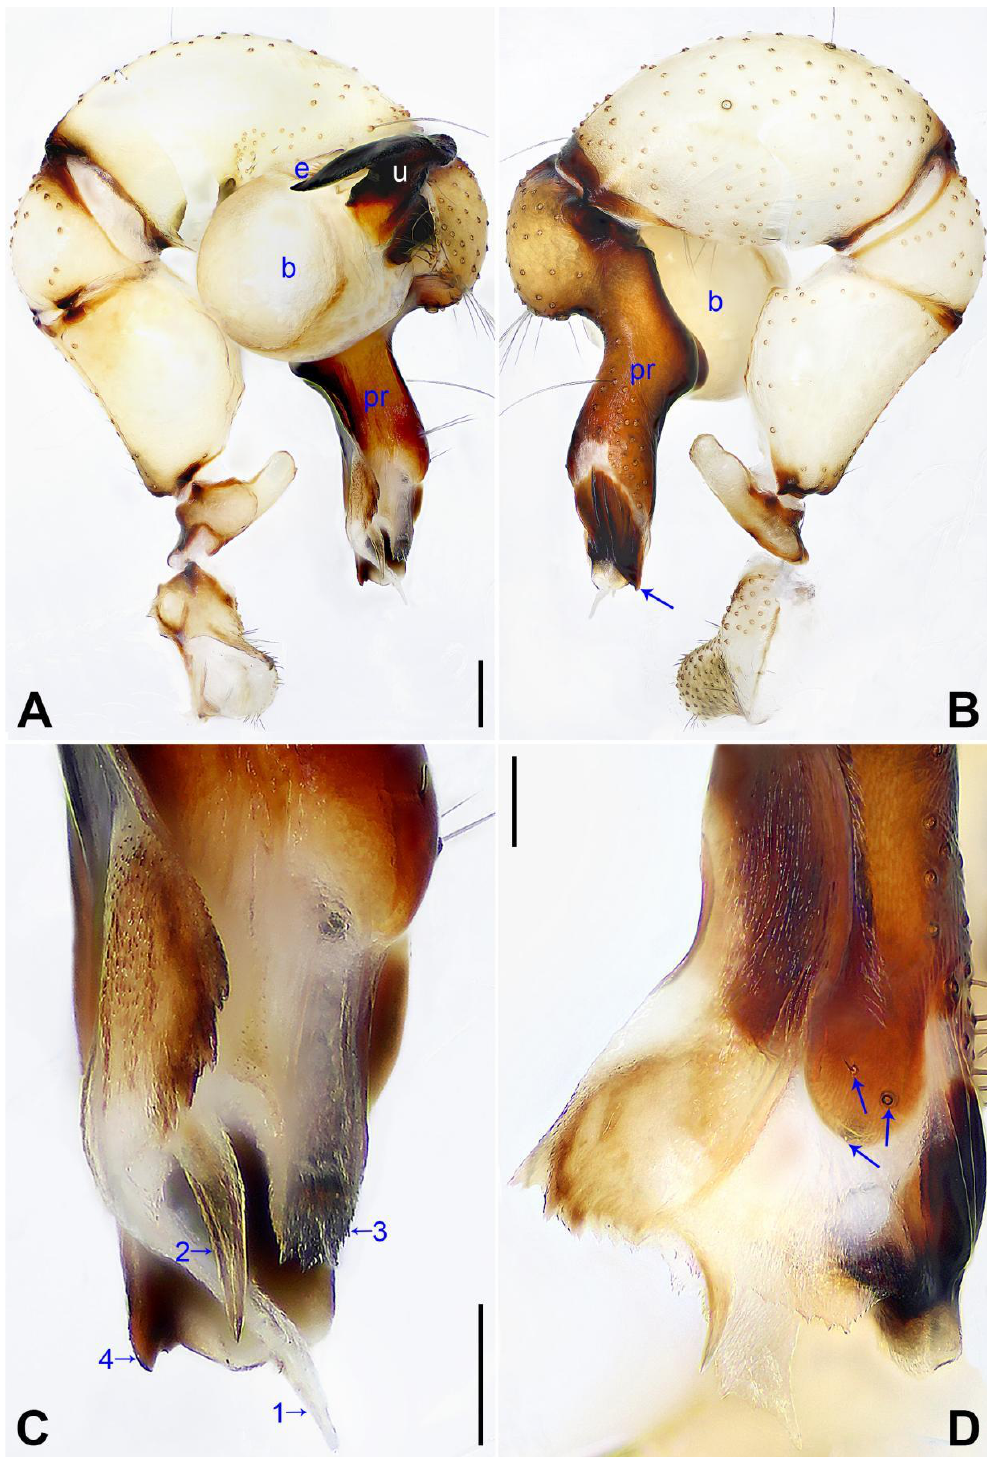
Figure 17. Pholcus zhongyang sp. nov., holotype male: ( A ) pedipalp, prolateral view; ( B ) pedipalp, retrolateral view (arrow points at ventro–distal apophysis); ( C ) distal part of procursus, prolateral view (arrow 1 points at prolateral membranous process, arrow 2 points at slightly sclerotized distal apophysis, arrow 3 points at dorsal membranous lamella, arrow 4 points at ventro–distal apophysis); ( D ) distal part of procursus, dorsal view (arrows point at dorsal spines). b = bulb, e = embolus, pr = procursus, u = uncus. Scale bars: ( A , B ) = 0.20 mm; ( C , D ) = 0.10 mm.